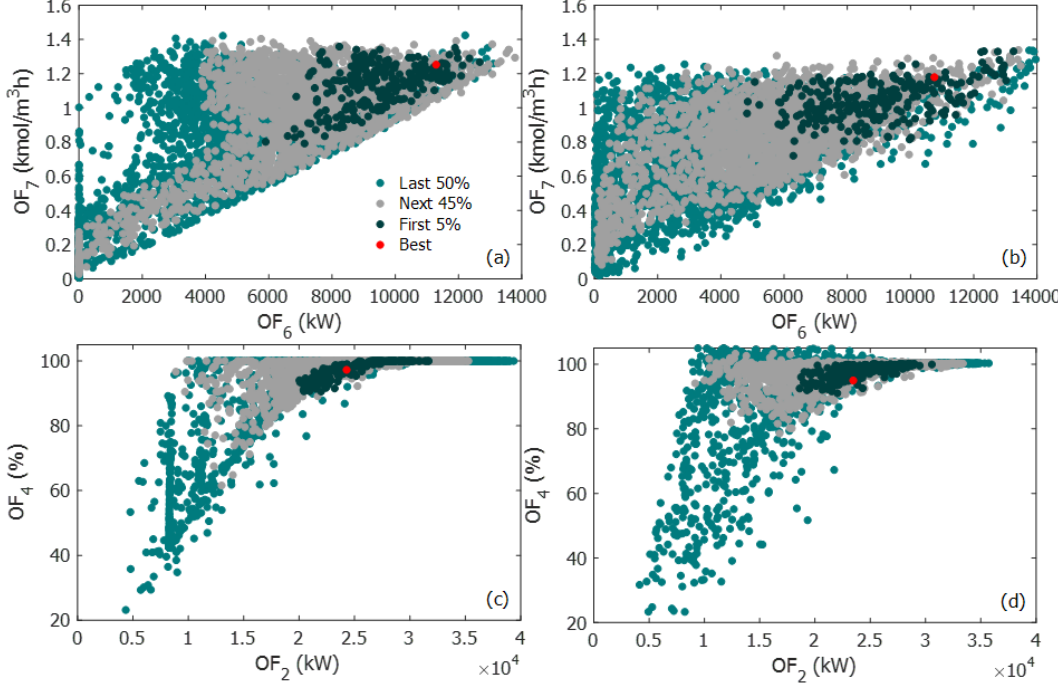
Figure 8. Ranked Pareto domain with net flow method (NFM) obtained with: ( a ) and ( c ) the phenomenological model and ( b ) and ( d ) the ANNs. Table 4. Objective functions of the best ranked solution using NFM from the Pareto domain obtained with a population of 5000; F P = 210.0 kmol/h, F A = 1507.9 kmol/h, F S1 = 206.6 kmol/h, F S2 = 100.0 kmol/h,